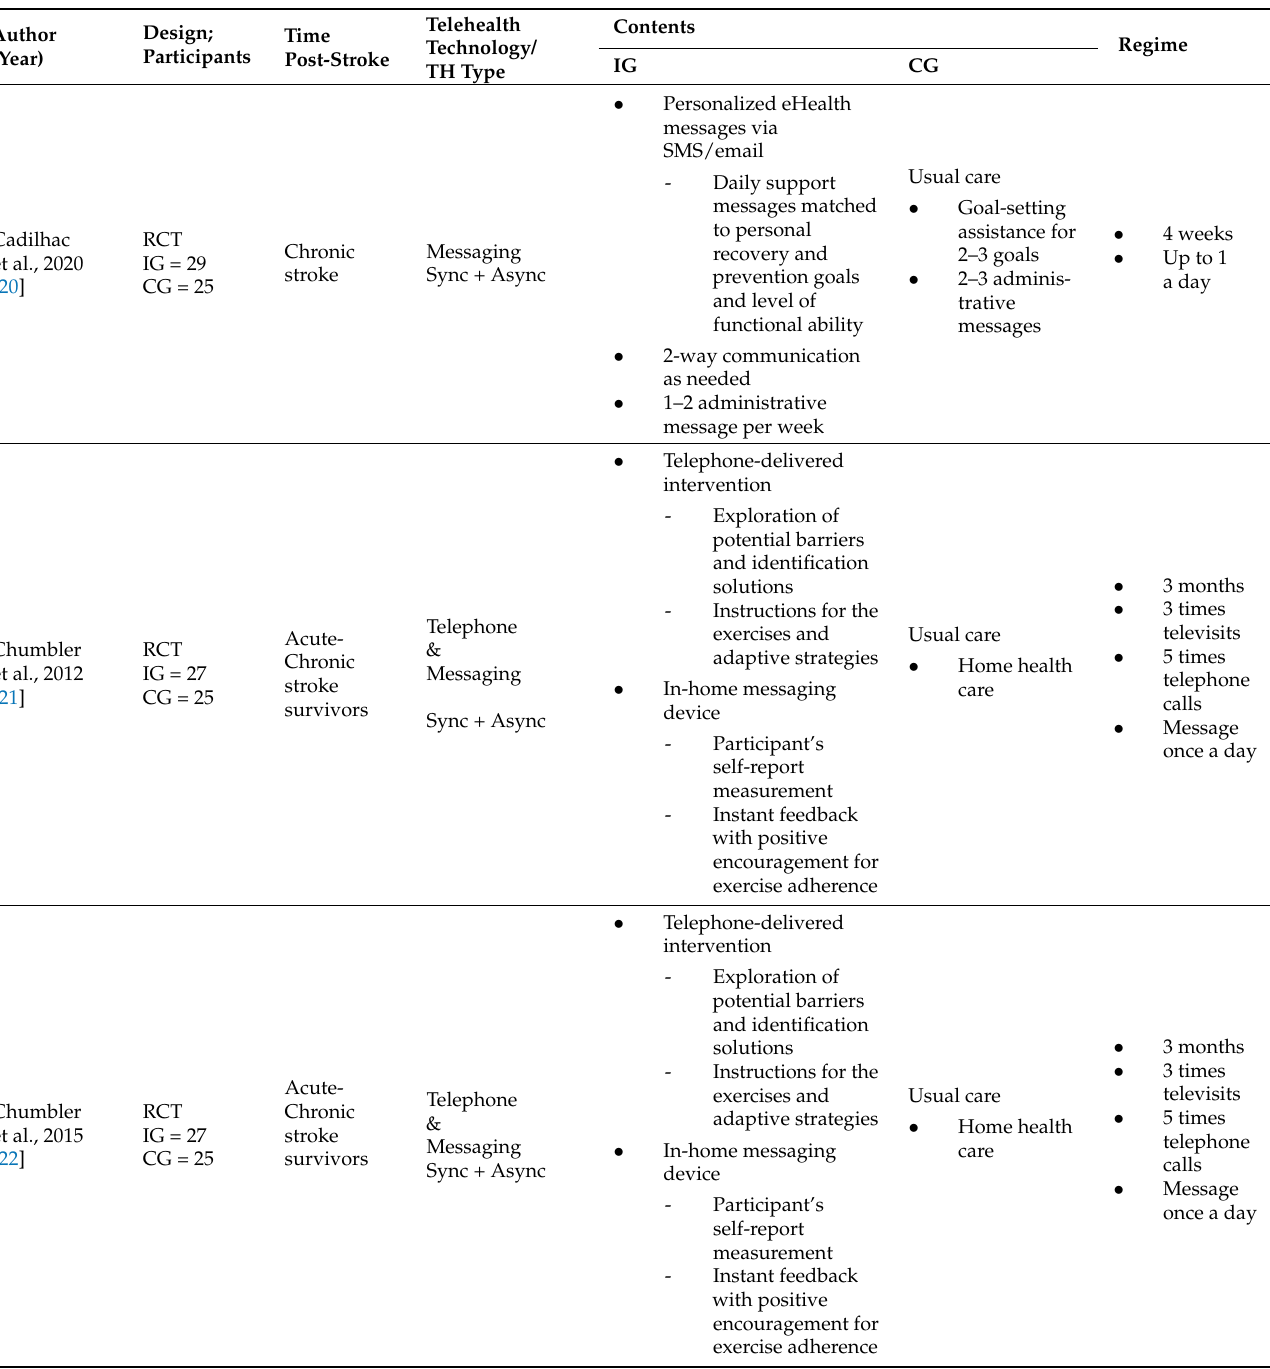
Table 3. Summary of studies investigating the use of TH-SM support